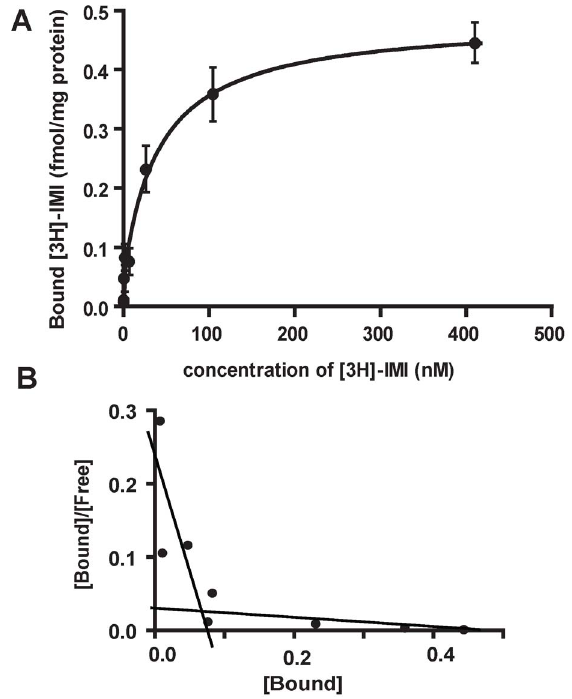
Figure 2. [ 3 H]-imidacloprid specific binding on pea aphid. Saturation curves (A) and Scatchard plots (B) for [ 3 H]-imidacloprid specific binding. Membranes were extracted from whole parthenoge- netic adults of pea aphid Acyrthosiphon pisum LSR1. Results are means of four experiments. Error bars represent the SEM.